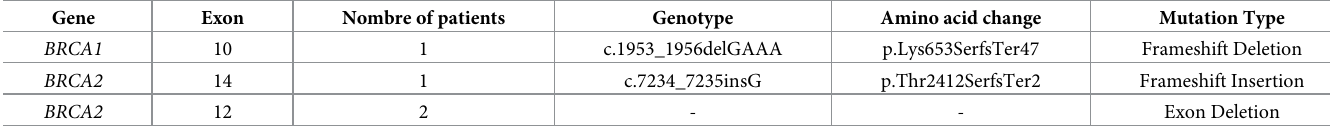
Table 2. Pathogenic BRCA1/2 mutations identified in the present